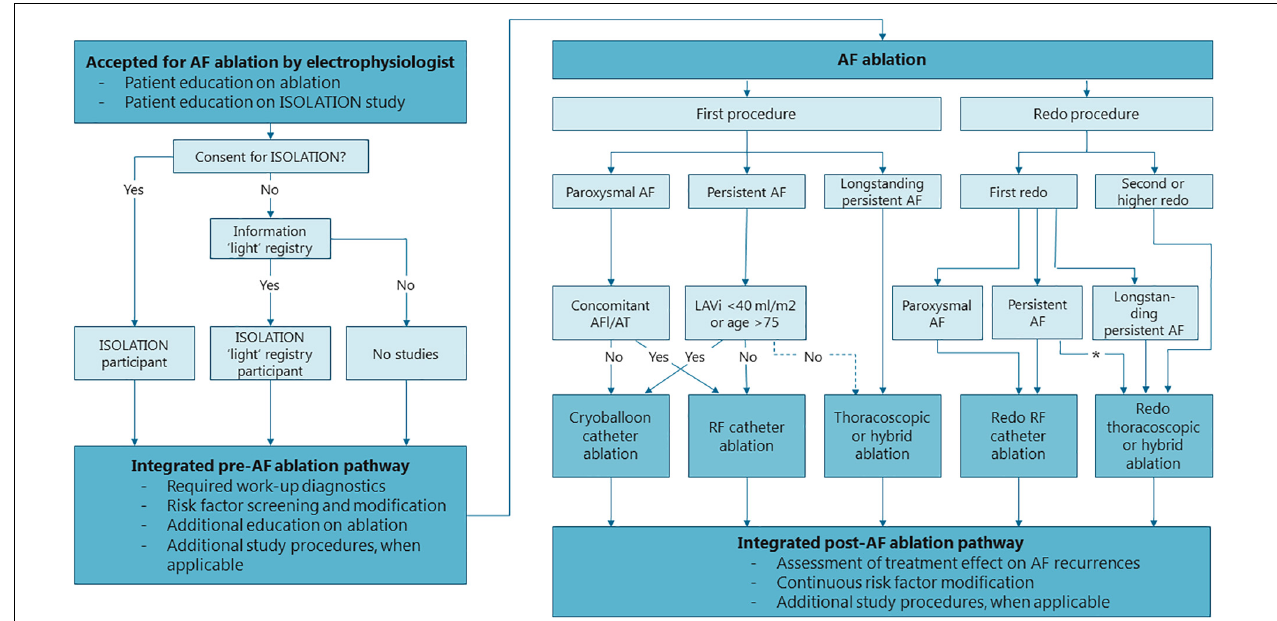
FIGURE 2 | Flowchart of the standardized, integrated clinical care and research pre- and post AF ablation pathway. Structure of the pre- and post AF ablation pathway and general recommendations for the type of AF ablation. Treating physicians may choose to deviate from these recommendations depending on specific patient characteristics of patient preference. ∗ Thoracocopic/hybrid ablation is strongly considered if LAVi >5 − ml/m 2 or in case of patient preference. AF, atrial fibrillation; LAVi, left atrial volume index; RF,